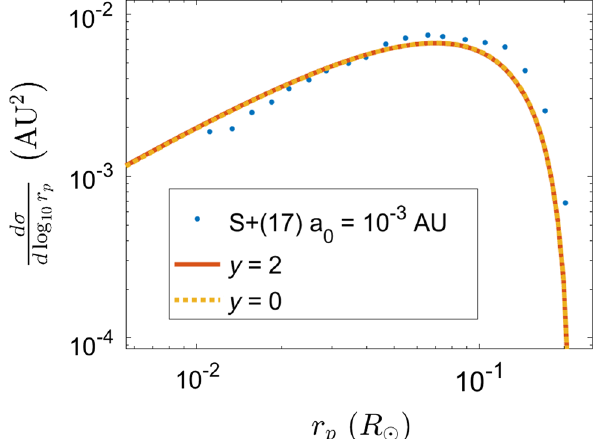
FIG. 4. Inspiral or collision cross section, as a function of y , for FIG. 5. Differential cross section for obtaining a final pericenter 10 − 3 AU, and v 10 km s − 1 . The purple line β ¼ 1 . 3 , a 0 ¼ 0 ¼ distance r p in an exchange or flyby, which is the integral over corresponds to the model of Eq. (67), while the blue line is for ð E bin ; S Þ of Eq. (71), multiplied by the relevant Dirac delta Eq. (66); the red line is the numerical result of Samsing et al. [28]. function. Note that y is defined below Eq. (63). This is compared As expected, the cross section converges to a constant for large with data from Samsing et al. [28] for a 0 ¼ 10 − 3 AU and enough y , despite some noise due to numerical integration. 10 km s − 1 , and both are normalized to give the same total v 0 ¼ exchange or fly-by cross section. To reduce computational difficulty here, Δ E ð u Þ is approximated to be equal to Δ E ðð 1 þ y Þ = 2 Þ for u < y , and zero otherwise. The y ¼ 2 case is indis- cernible from the tideless case, y ¼ 0 , in agreement with Samsing et al. ’ s result that tides do not change the exchange or flyby cross section